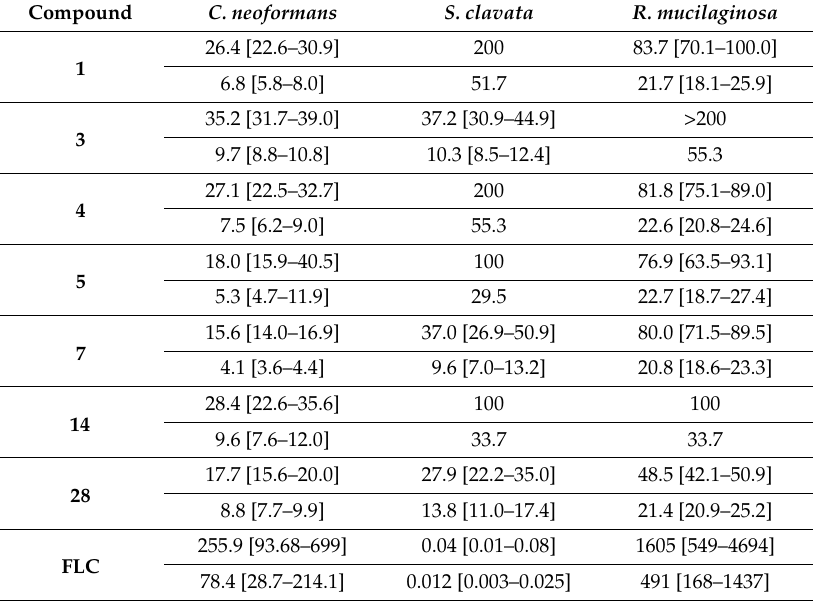
Table 4. Antifungal effect determined for compounds 1 , 3 - 5 , 7 , 14 , 28 and for the control FLC against various non- Candida yeast strains. The activities are expressed as IC 50 values a,b [ µ M (above) and in µ g/mL